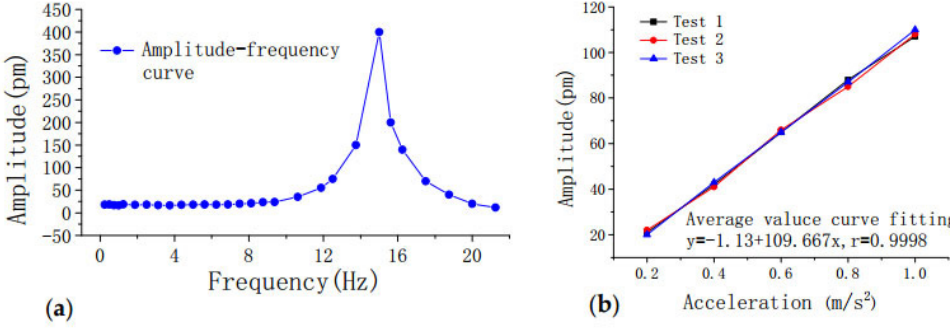
Figure 13. Performance test of the fiber Bragg grating (FBG) vibration sensor: ( a ) amplitude-frequency curve; ( b ) acceleration characteristics curve [152] .